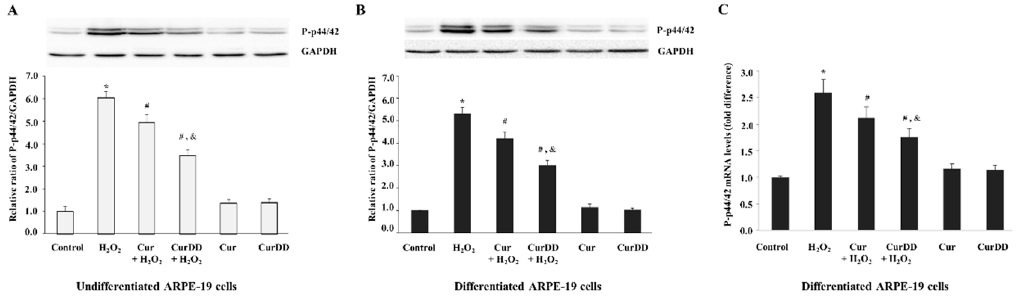
Figure 5. Protective effects of Cur and CurDD against oxidative stress occur through modulation of apoptotic MAPK p44 / 42 signalling pathway. ARPE-19 cells were pre-treated with 10 µ M of Cur or CurDD for 24 h, followed by H 2 O 2 treatment at appropriate concentrations (400 and 200 µ M for undifferentiated and differentiate cells, respectively) for 6 h. Protein levels of phosphorylated P-p44 / 42 were assessed by immunoblotting in ( A ) undifferentiated and ( B ) differentiated ARPE-19 cells. GAPDH immunodetection was used as a loading control. Representative Western blots shown, with graphs presenting average normalised protein expression; ( C ) mRNA levels of p44 / 42 were analysed by qPCR. Graph represents average expression normalised against four housekeeping genes as described in Methods. (For both protein and mRNA, data is presented as mean ± SD values, n = 4; One-Way ANOVA test, * p ≤ 0.05 vs. control group, # p ≤ 0.05 vs. H 2 O 2 group, and & p ≤ 0.05 vs. Cur + H 2 O 2 group).